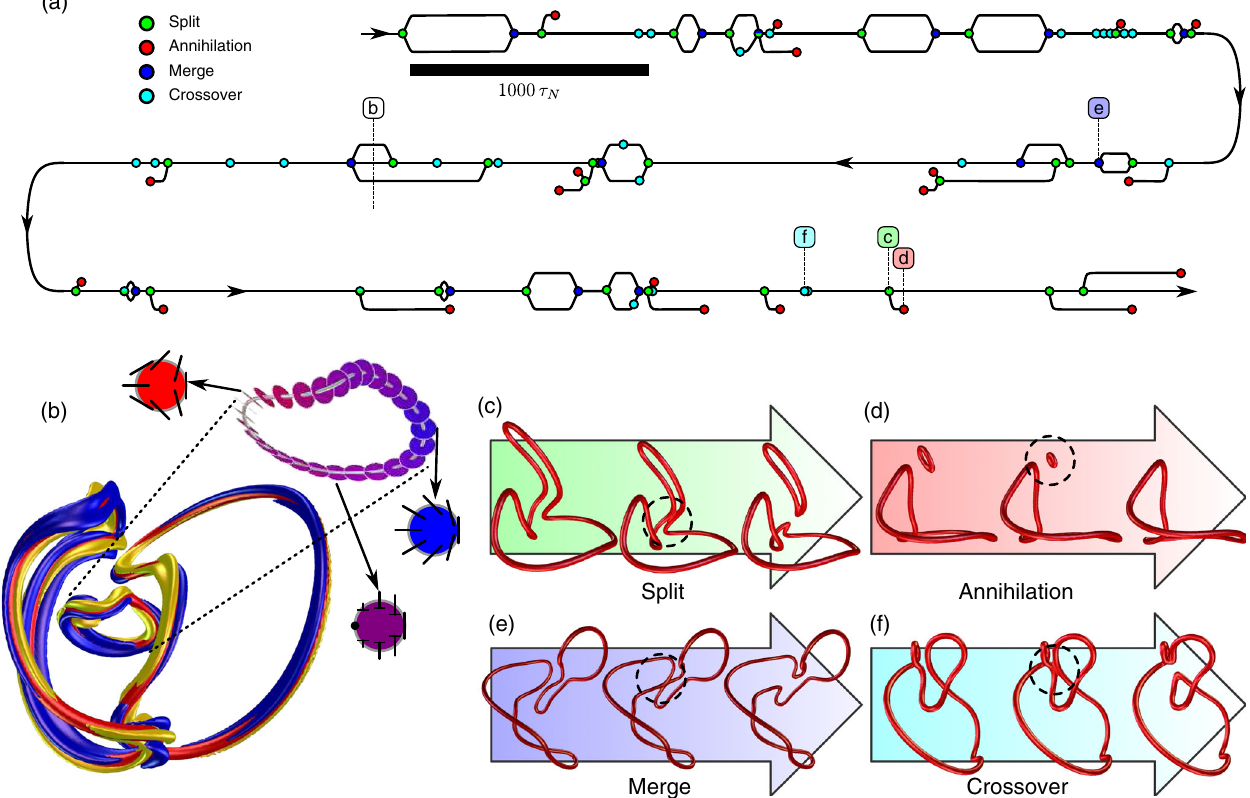
FIG. 3. Topological events in turbulent regime. (a) Graphically depicted topological flow diagram for the active nematic defect loops in a selected time interval. Note that the diagram time axis is to scale (black line) and is given in units of the intrinsic nematic timescale τ . At all times, one of the loops carries topological charge þ 1 , and the others have zero charge. (b) A snapshot of active turbulence with N three loops. The color coding of the disks for the selected defect loop shows the type of local profile of the defect line, where blue refers to þ 1 = 2 , red to − 1 = 2 winding number, and purple to the local twist defect line profile. The variation of the defect line cross section is also illustrated more qualitatively with the splay-bend parameter (yellow and blue isosurfaces). (c) – (f) Time sequences of selected loop topology-changing events: splitting, annihilation, merging, and crossover. Panel (c) shows splitting of a neutral loop (upper) from a loop with a þ 1 topological charge (lower). The neutral loop soon annihilates in panel (d). The droplet radius is R ¼ 136 ξ N , and the activity is ζ ¼ 0 . 04 L= ξ 2 N